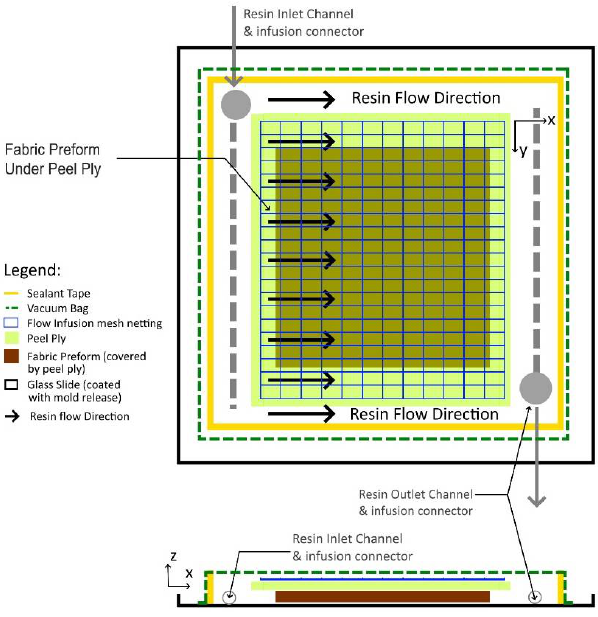
Figure 4. Vacuum infusion schematic (not drawn to